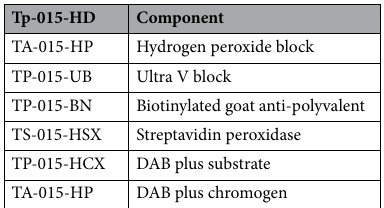
Table 4. Reagent of ultra vision detection system (anti-polyvalent, HRP/DAP) for